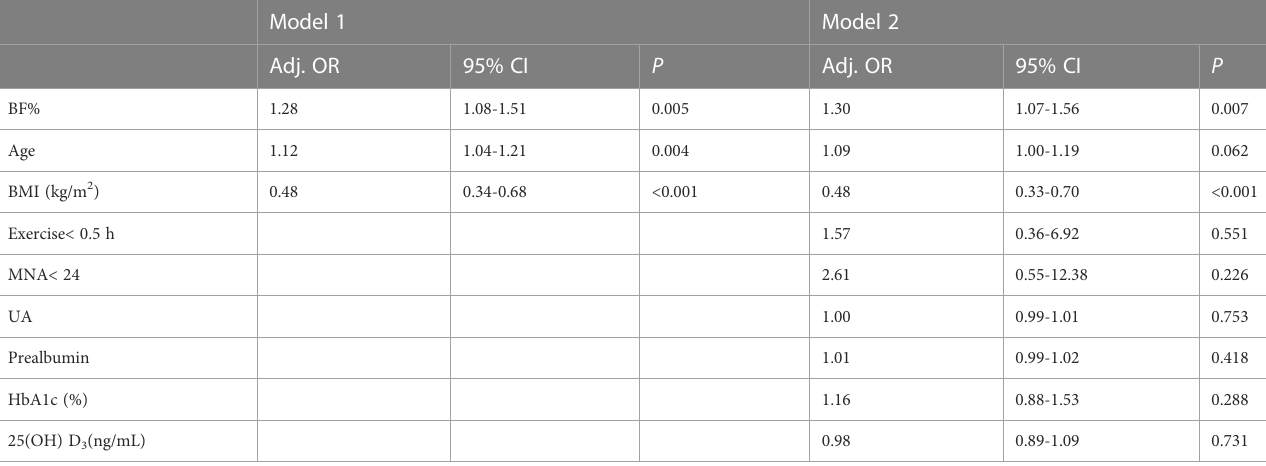
TABLE 4B Logistic regression models for risk factors associated with sarcopenia